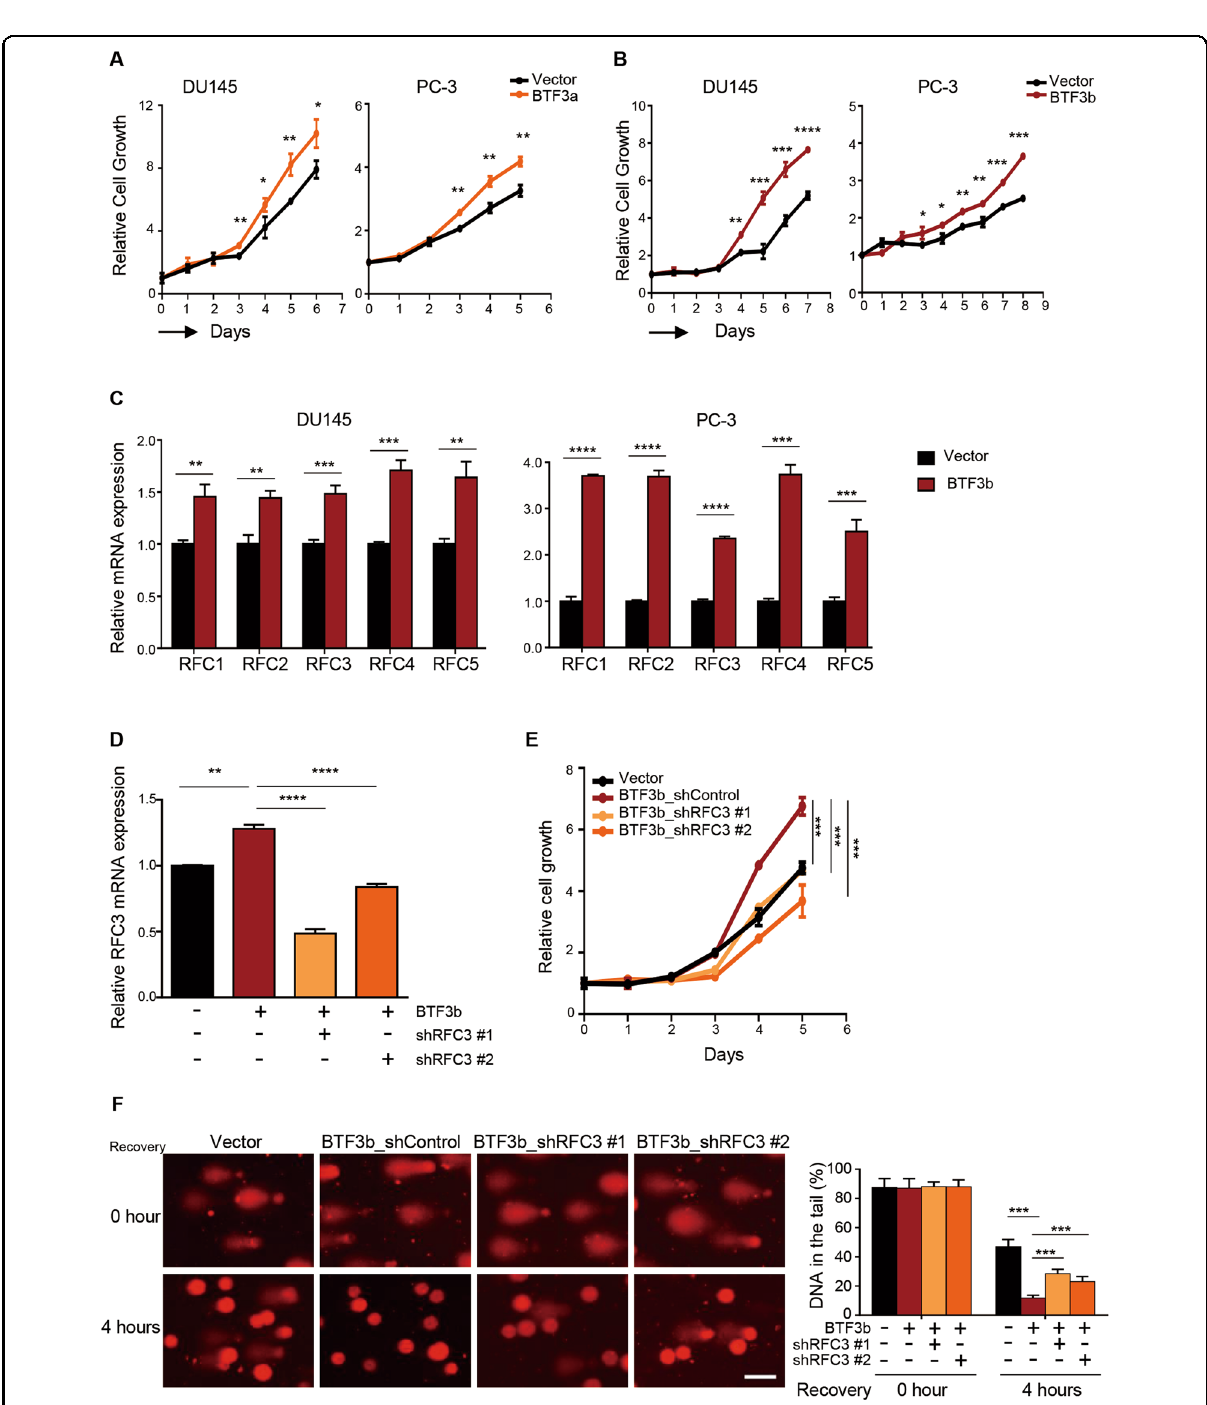
Fig. 5 Knockdown of RFC3 partially attenuated the growth advantage and DNA damage repair capability incurred by BTF3b- overexpression. a , b Relative cell growth of DU145 and PC-3 prostate cancer cells with or without ectopic BTF3a ( a ) or BTF3b ( b ) overexpression. Mean ± S.D. for three independent experiments are shown. * p < 0.05, ** p < 0.01, *** p < 0.001, **** p < 0.0001 (Student ’ s t -test). c qRT-PCR analysis of the RFCs mRNA levels was conducted in DU145 (left panel) and PC-3 (right panel) prostate cancer cells with or without ectopic BTF3b overexpression. d qRT-PCR analysis of RFC3 mRNA levels was conducted in DU145 cells as indicated. ACTB was used as an endogenous control. Data are shown as mean ± S.D. from three independent experiments. ** p < 0.01, *** p < 0.001, **** p < 0.0001 (Student ’ s t -test). e Relative cell growth of prostate cancer cells as in d . Data are shown as mean ± S.D. for three independent experiments. *** p < 0.001 (Student ’ s t -test). f The effect of RFC3 silencing on the extent of DNA damage in BTF3b-overexpressing DU145 cells was measured by alkaline comet assay. Cells were harvested at the indicated time points after a 30-min treatment with H 2 O 2 (100 μ M). Scale bar, 50 μ m. Quanti fi cation of DNA in the tail is shown as mean ± SD. *** p < 0.001 (Student ’ s t